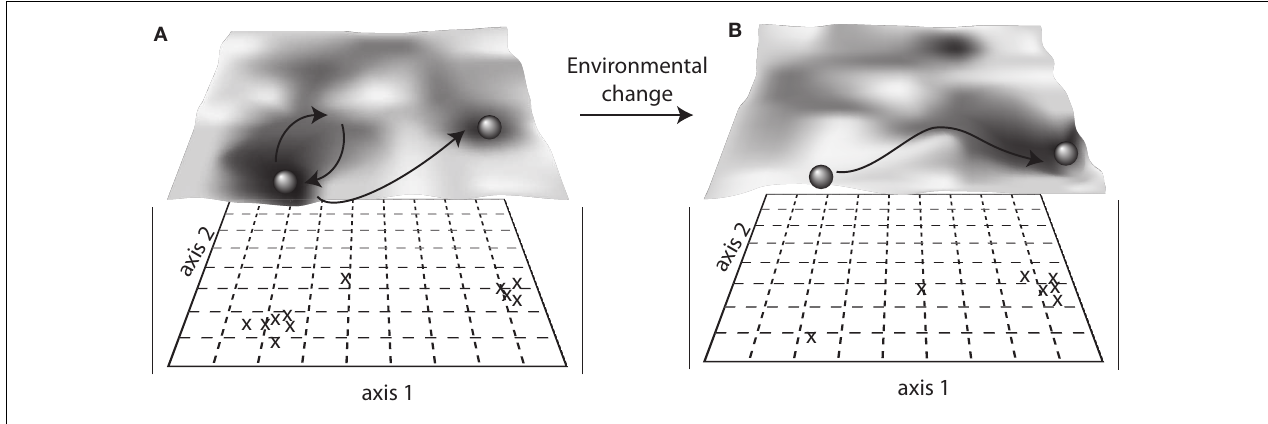
shows the different stable states as basins, and the community is represented as a ball that is either maintained in its original basin or displaced to a new basin after a disturbance. Community resilience is represented by the slope of the basin walls, showing a rate of return to the original stable